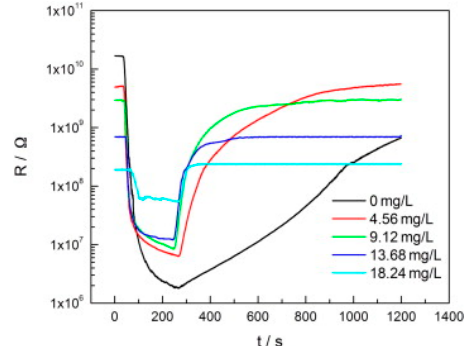
Figure 16. 100 ppm formaldehyde UV-activated sensing results for TiO 2 vs. humidity at room temperature. Reproduced with permission from [51]. Micromachines 2017 , 8 , 333